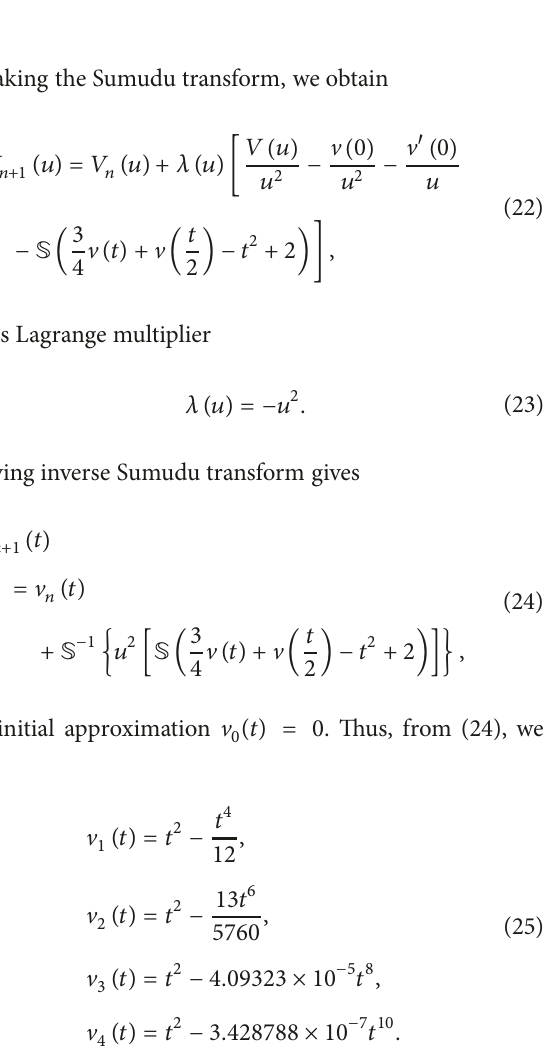
Figure 1: Graphs of the absolute errors for some values of 𝑡 with LVIM and SVIM for Example 1.